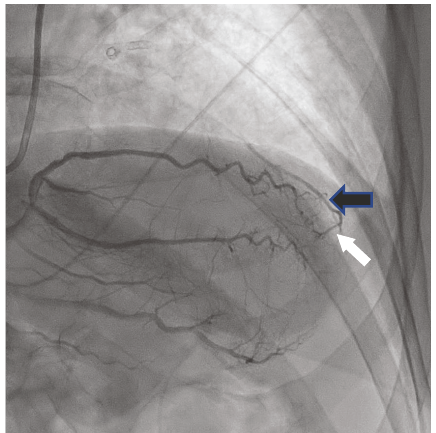
Figure 2: Epicardial vessel from the distal right coronary artery (white arrow) collateralizing the diagonal branch (black arrow).